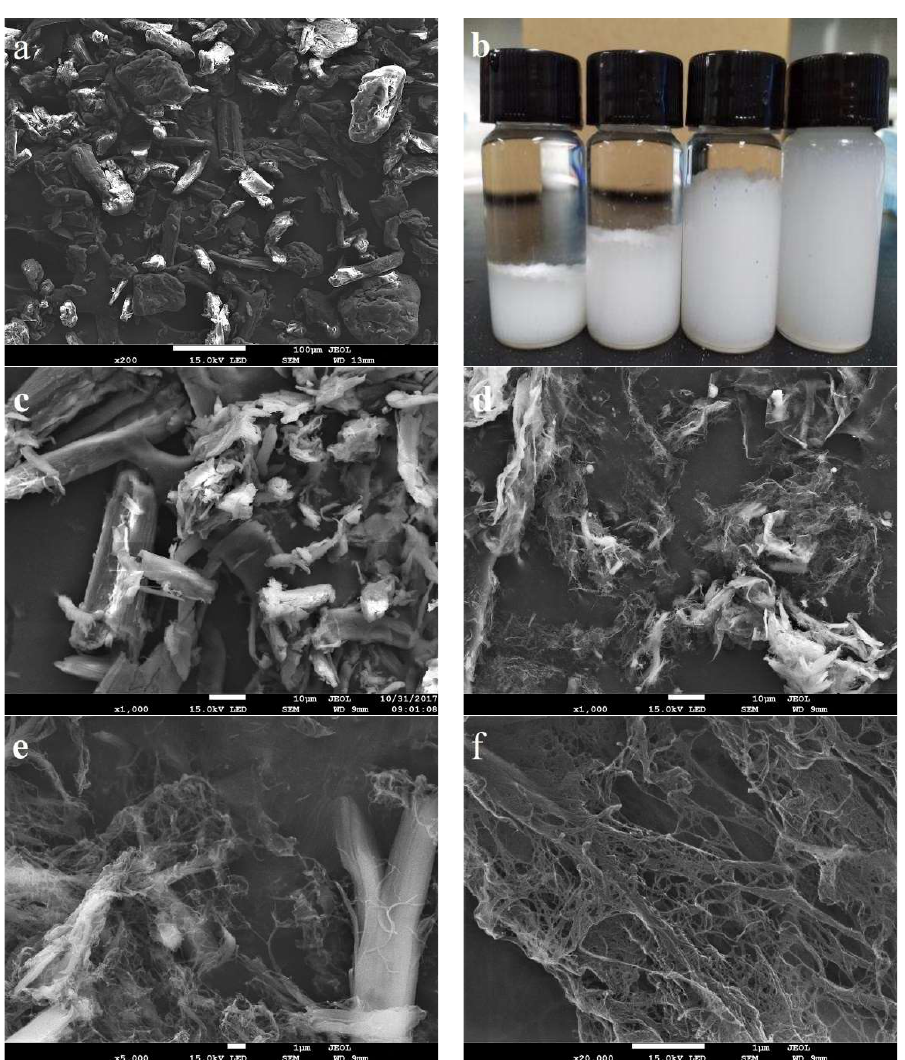
Figure 1. SEM images of MCC ( a ) and a freeze dried cellulose nanofibril (CNF) ( c – f ), and their visual appearance ( b ) after 30 days of storage: from left to right ( c ) enzymatic pretreated MCC; ( d ) CNF-2-pass, ( e ) CNF-5-pass, and ( f ) CNF-10-pass.